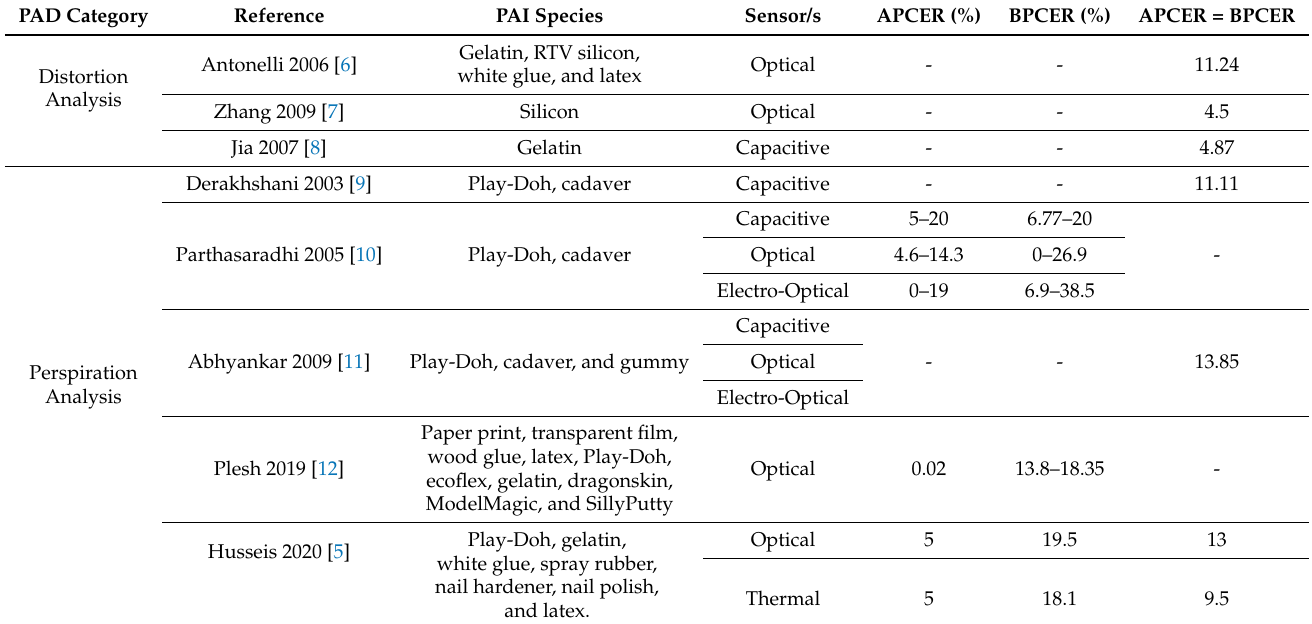
Table 1. Performance analysis for the SoA fingerprint PAD mechanisms (reported in